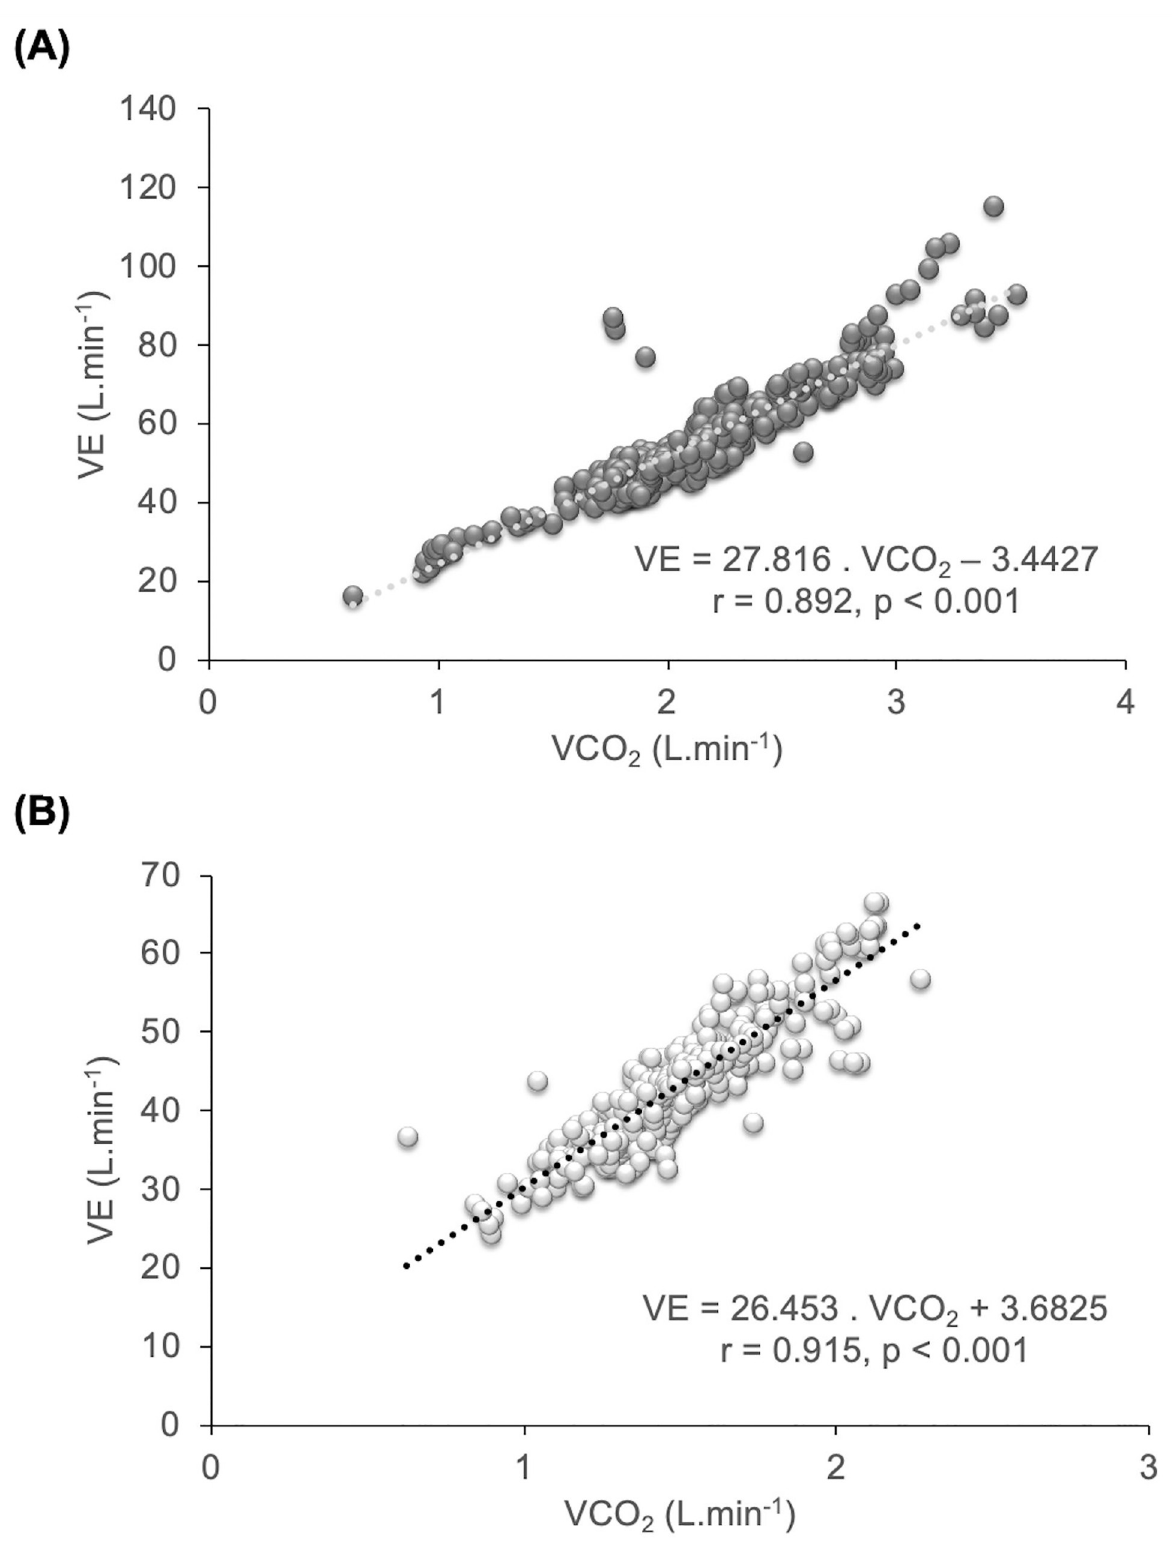
Fig 4. Linear relationship between ventilation (VE) and carbon dioxide (VE/VCO2 slope): (A) Cycle ergometer (CYC). (B) Half-squat (HS).